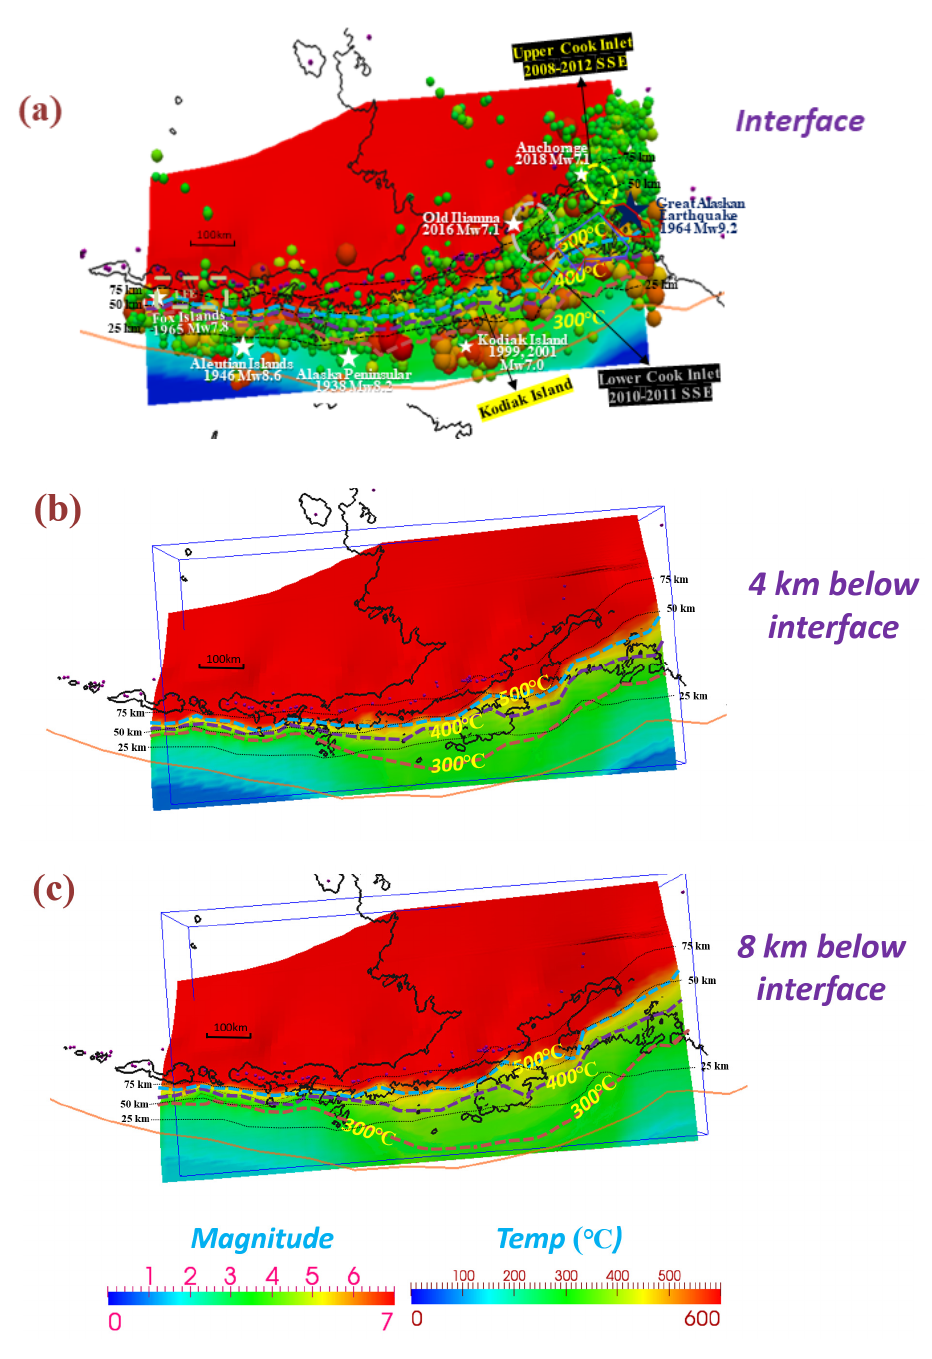
Figure 3. Slab temperatures were calculated vertically below the interface at depths of ( a ) 0, ( b ) 4, and ( c ) 8 km. The black dashed lines represent the interface isodepth contours of 25, 50, and 75 km. The yellow and gray dashed circles represent the slow slip event patches in the Upper Cook (2008–2012, [17]) and Lower Cook Inlets (2010–2011, [18]). The green dashed line indicates low- frequency earthquakes [20]. Bold blue lines indicate the 1992.0–2004.8 (~M 7.8) Slow Slip Event, and bold red lines indicate the 2009.85–2011.81 (~M 7.2) Slow Slip Event [21,22]. The blue, purple, and dark red dashed lines represent the isotherm contours of 500, 400, and 300 ◦ C,